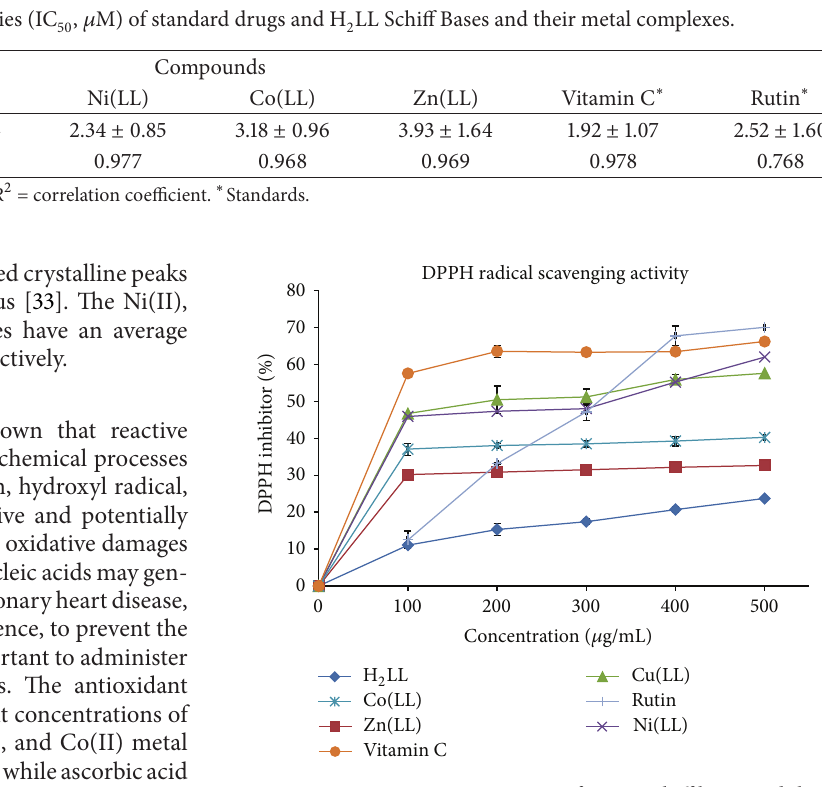
Table 4: DPPH scavenging capacities (IC